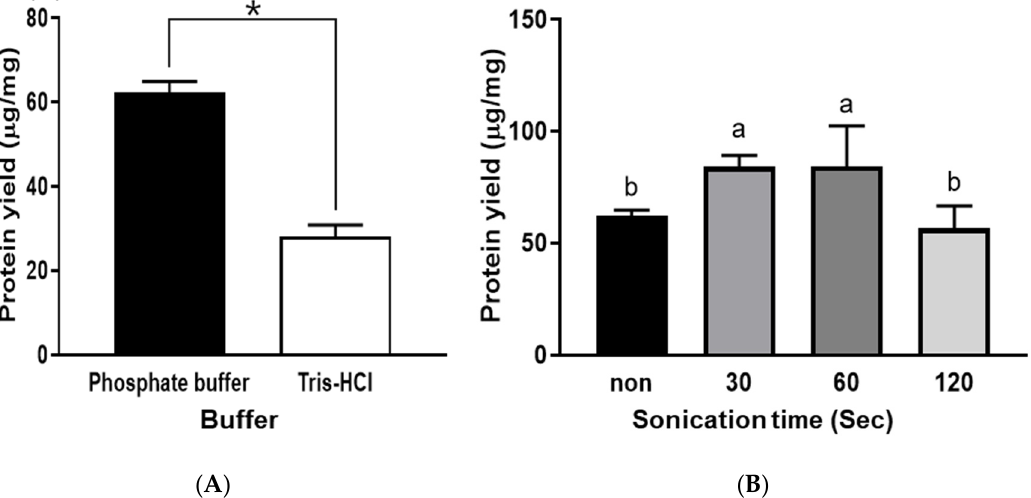
Figure 1. Protein yields were obtained using different buffer types ( A ) and the application of various ultrasonication times ( B ). Bars with symbols (*) or different letters (a and b) are significantly different ( p < 0.05).